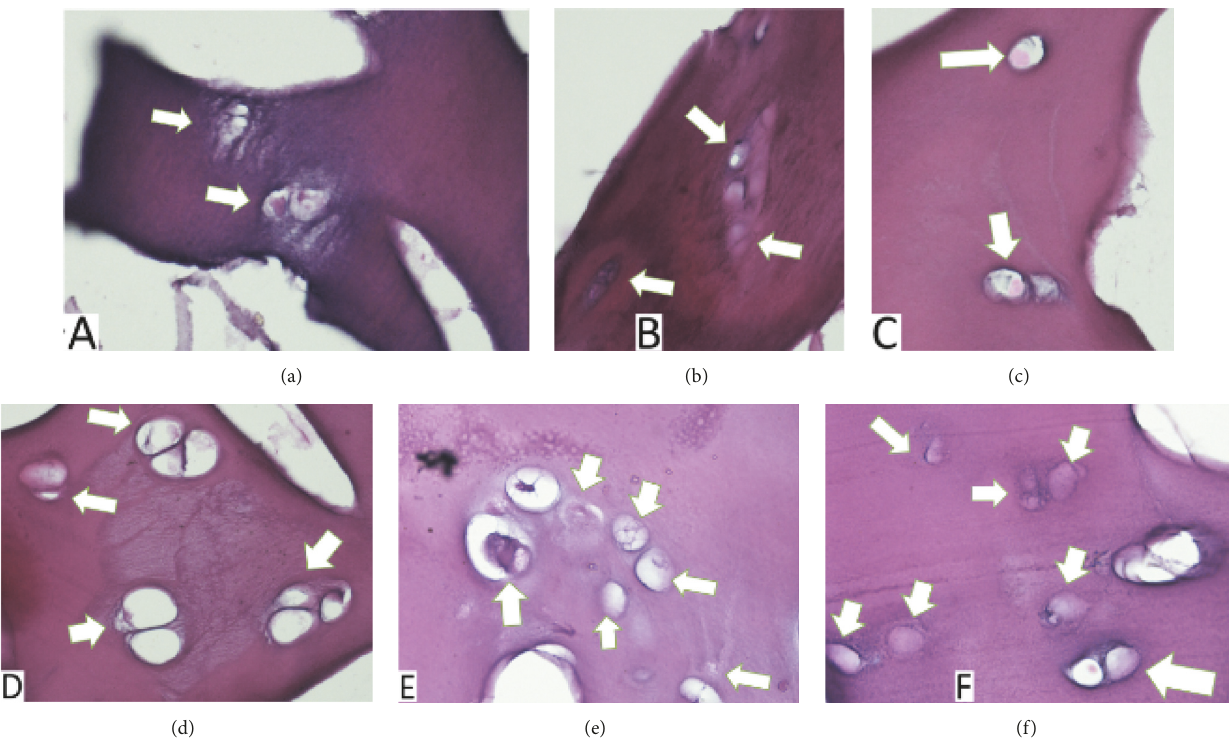
Figure 10: Hematoxylin-Eosin staining in 4 weeks after hBM-MSCs seeding. (a-c) SBCS group and (d-f) DSBCS group. White arrow showed